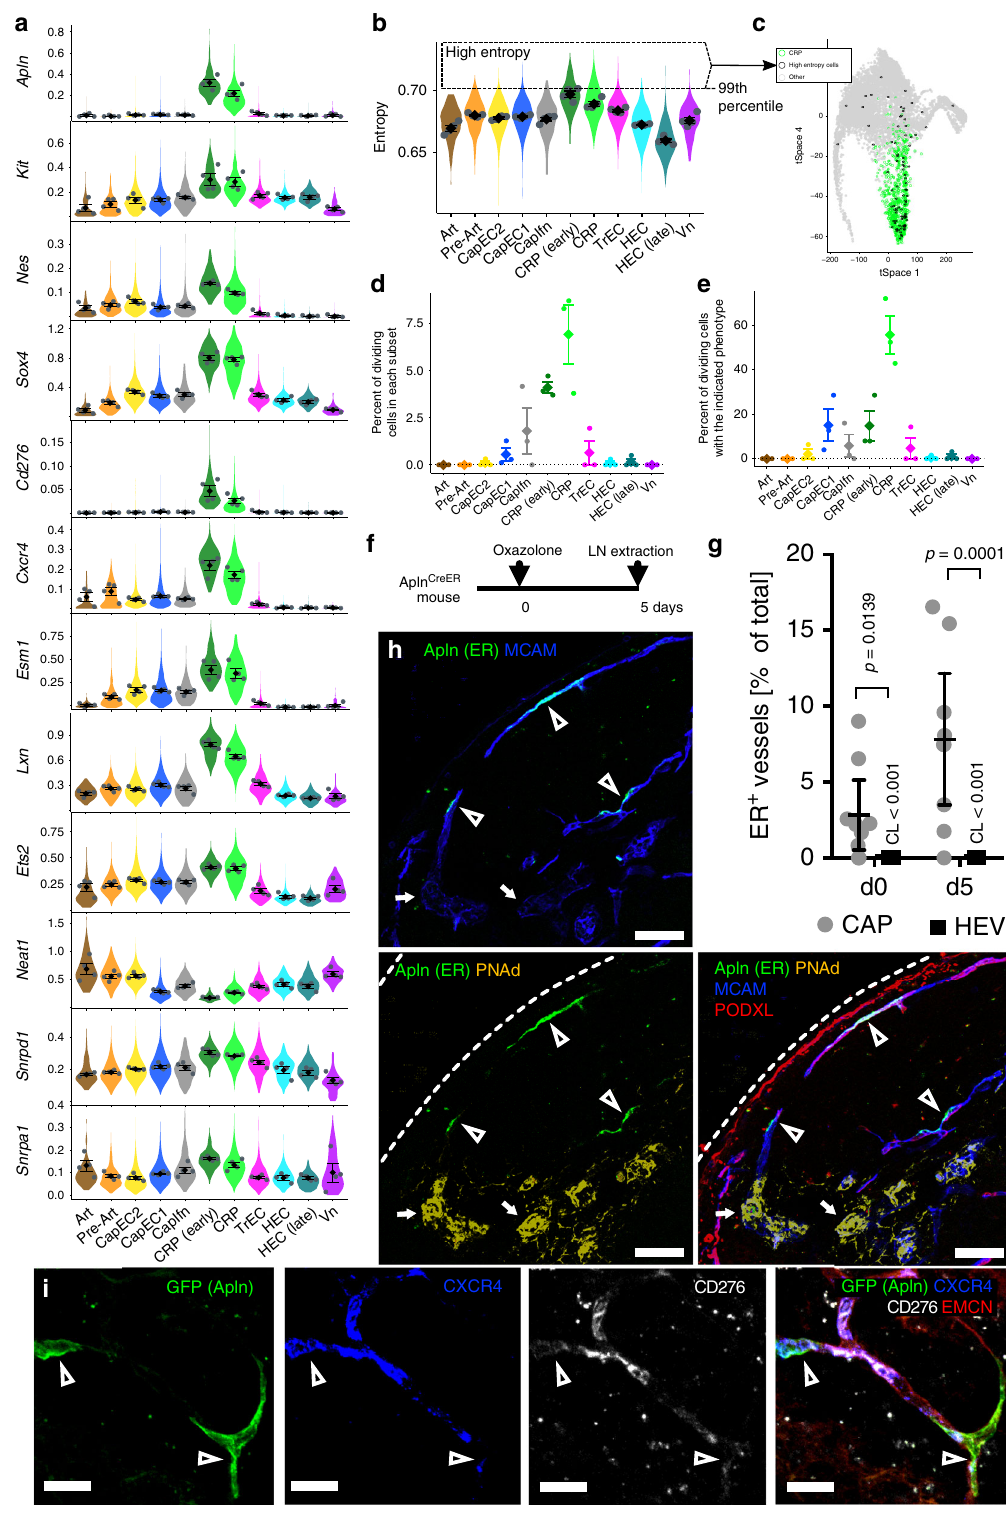
these correlates of potency, including high entropy; however, cells with the highest entropy tend to map to the ‘ origin ’ of the CRP branch in trajectory space (Fig. 5c). Finally, CRP express Angpt2 , Apln , Esm1 , Nid2 , Pdgfb , and Pgf (Fig. 1f), genes characteristic of angiogenic tip cells, precursors to new vessels formed during sprouting angiogenesis 37,38 . Together these observations